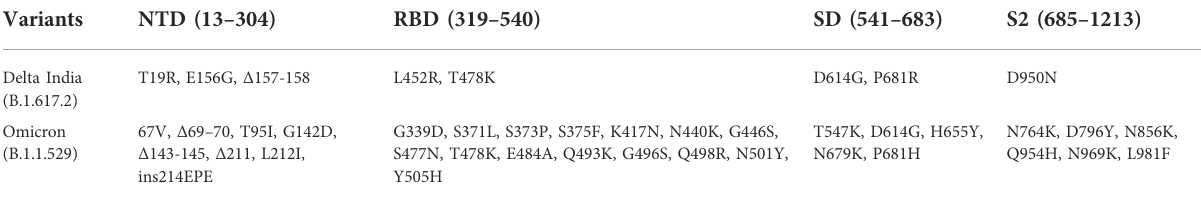
TABLE 1 SARS-CoV-2 S-protein variants. Positively charged mutations in RBD and furin cleavage sites are shown in red.